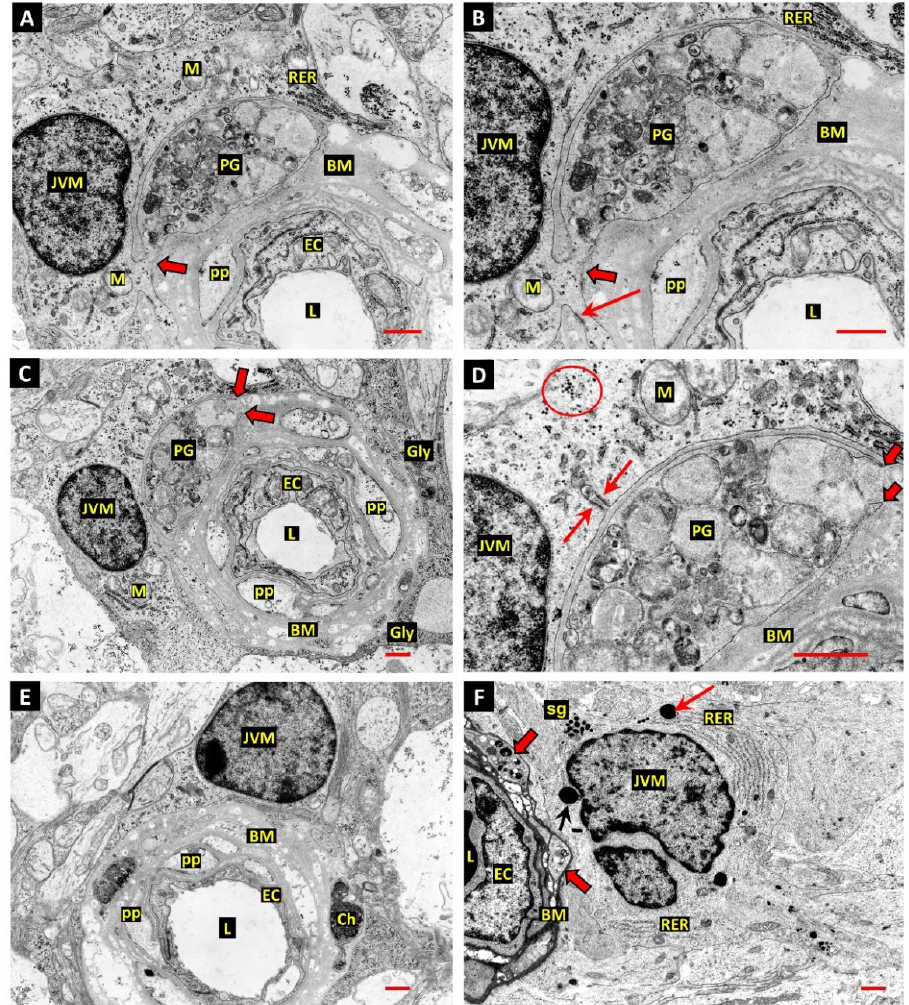
Figure 1. ( A , B ) Electron micrograph of a retinal capillary from a diabetic donor eye shows a pericyte “ghost” (PG) filled with vacuolar remnants of extreme autophagic activity within the vascular basement membrane (BM). The PG is undergoing phagocytosis by a perivascular microglial cell (JVM). The process of the JVM engaged in phagocytosis has infiltrated the BM but shows cytoplasmic continuity with the cell of origin (thick arrow). An adjacent process of the JVM shows anchorage to the BM via a well-developed hemi-desmosome-like attachment plaque (arrow, panel B ). The JVM shows distinctive aggregates of rough endoplasmic reticulum at the periphery of the cell body (RER). Vascular lumen—L; endothelial cells—EC; pericyte processes—pp; mitochondria—M; bars 1.0 µ m. ( C , D ) The deeper Z-plane of retinal capillary depicted in panels A , B provides additional detail of PG phagocytosis by the JVM cell. The extremity of the JVM process engaged in PG engulfment shows the tapered double-membrane ends of phagocytic pseudopodia (thick arrows). This profile also revealed an interesting form of matrix attachment by the JVM cell: 2 of the hemidesmosome-like attachments observed in panels A , B are anchored on the same tag of basal lamina (arrows). The cytoplasm of JVM was typically paler and lacked the dense aggregates of stored glycogen observed in the adjacent macroglia end-feet of the glia limitans (Gly in panel C ). However, discrete groups of glycogen particles were common throughout the JVM cytoplasm (ringed in panel D ). Bar 1.0 µ m. ( E ) Another example of a JVM cell, which has commonalities with that depicted in panels A , B ,